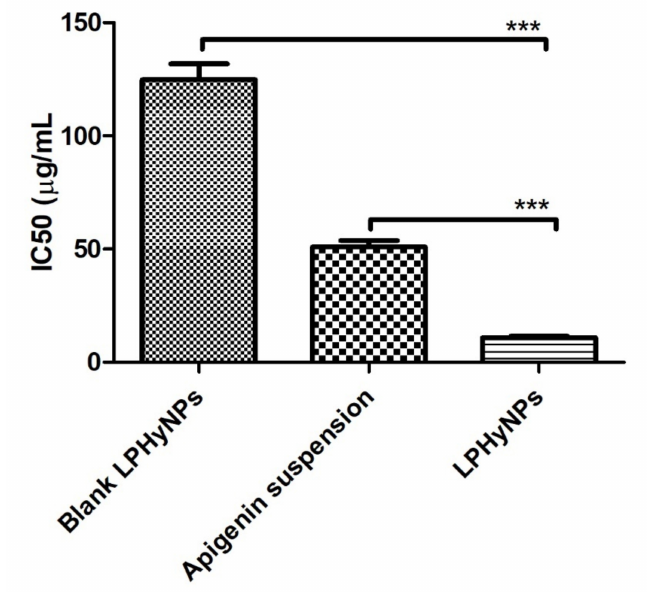
Figure 7. Showing the outcome of MTT assay for blank LPHyNPs, AGN suspension, and LPHyNPs. Values are presented as mean ± SD where p < 0.001) was represented by